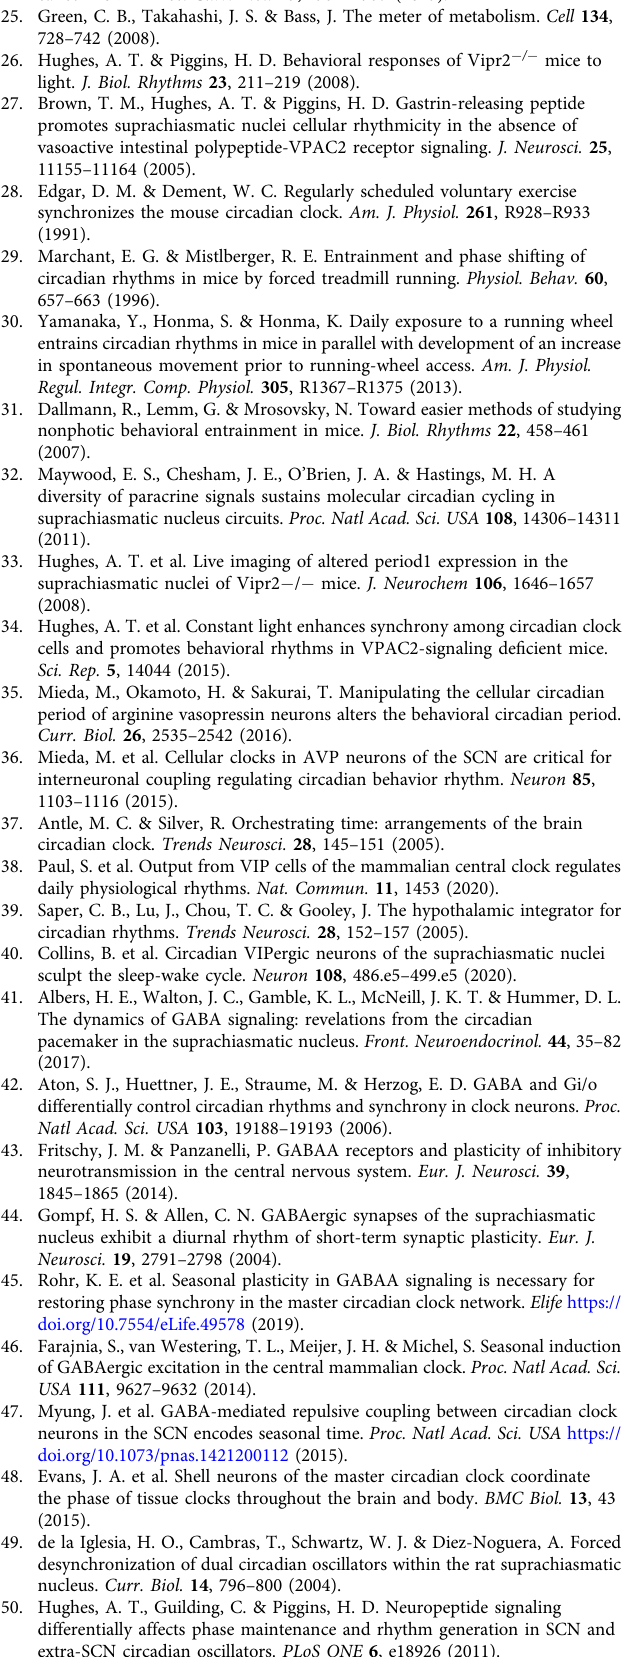
sample sizes, summary values, and dispersion can be found in the fi gure legends and main text. For all statistical tests, p <0.05 was required for signi fi